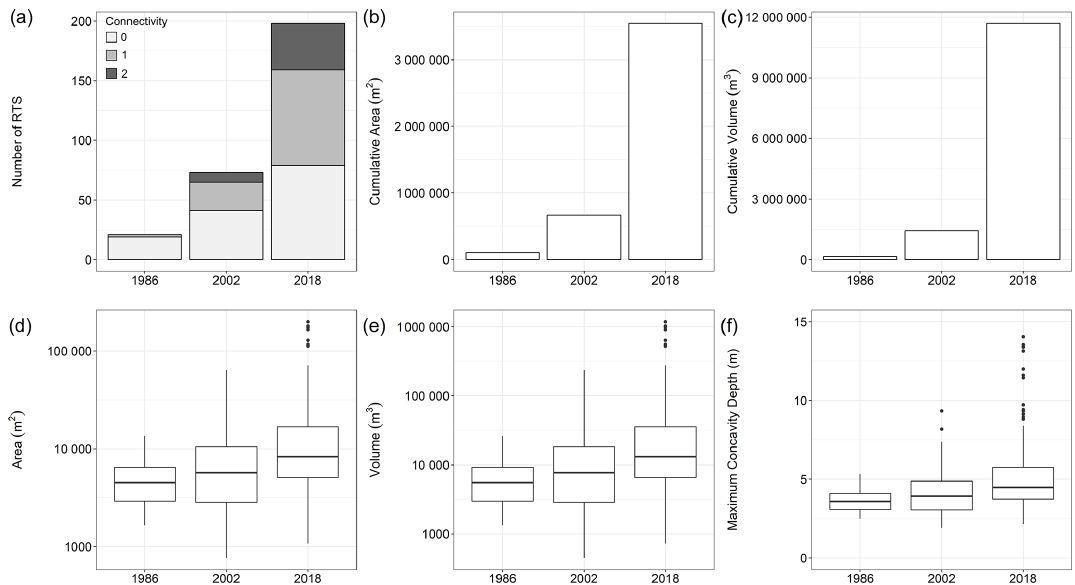
Figure 5. Thaw-driven geomorphic disturbances in the Willow River catchment for 1986, 2002, and 2018. Bar graphs show (a) retrogressive thaw slump (RTS) counts and connectivity between the slope and downstream environments categorized as 0 for no connectivity, 1 for a physical connection between the bare scar area and downstream environment, and 2 for evidence of downstream deposition of materials into the valley, stream channel, or lake. (b) Cumulative slump area and (c) estimated cumulative slump volume. Box-and-whisker plots showing medians, 25% and 75% quantiles, minimum and maximum values, and outliers for (d) thaw slump area, (e) approximated volumes, and (f) maximum concavity depths. Note the logarithmic scale in (d) and (e) . Thaw slump volume and maximum concavity depths are estimated using relationships described in Sect. 3.3 and Fig. 4. The spatial dataset is available in Rudy and Kokelj (2020).